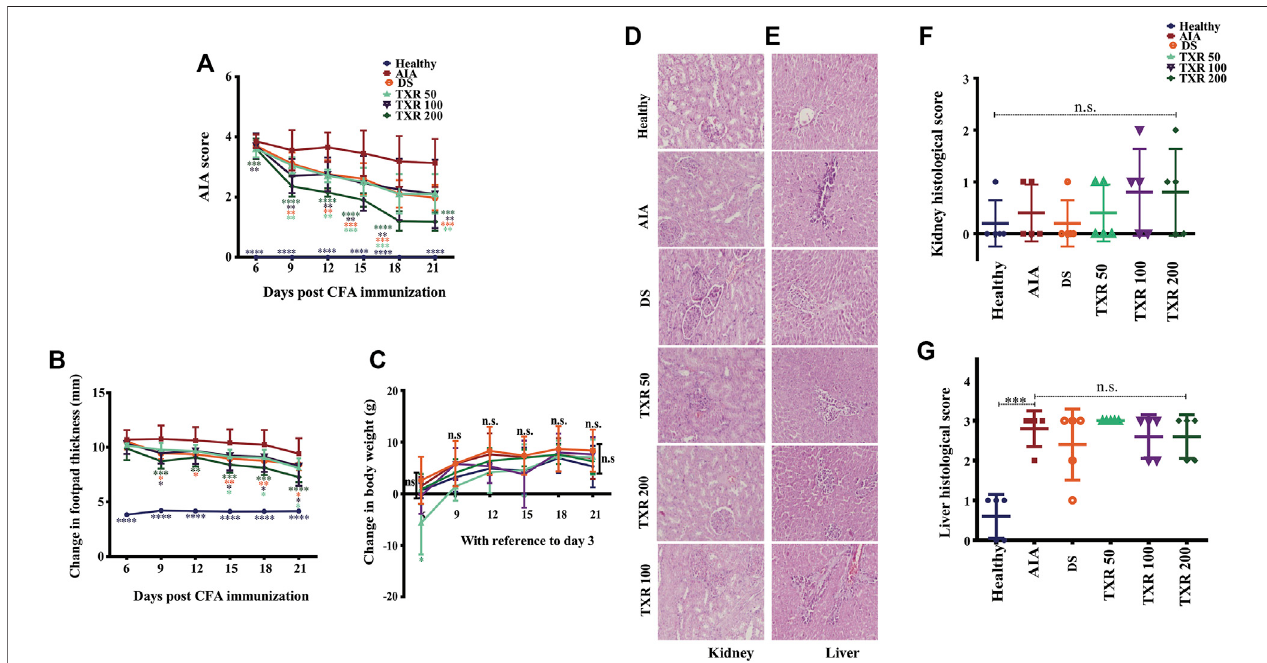
FIGURE3| TXRtreatmentsuppressesarthritisscoresinadjuvant-inducedarthritisratsinadose-dependentmanner.Thearthritisscore(mean±SD) (A) ,changein footpad thickness and (B) change in the body weight, (C) show a trend with TXR administration. Photomicrographs of hematoxylin and eosin-stained histological slides of the kidney (D) and liver (E) of rats of different study groups. The histological scores of kidneys (F) and liver (G) were derived from the analysis of different parameters. n.s.: not signi fi cant at 95% con fi dence and p -value of less than 0.05 was considered as signi fi cant. * p < 0.05, ** p < 0.01, *** p < 0.001, **** p < 0.0001.